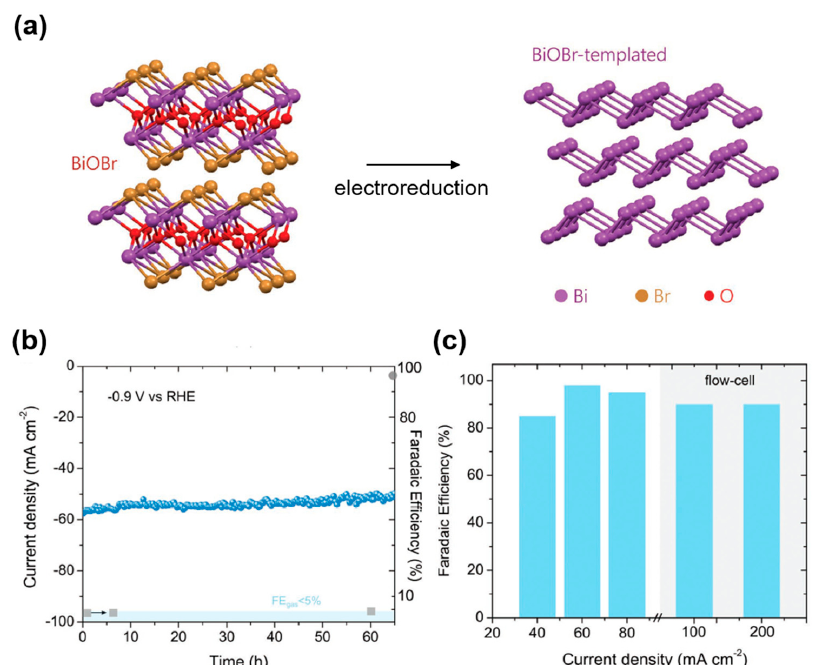
Figure 12. The characteristics of bismuth oxyhalide-templated catalysts. ( a ) Atomic structures of BiOBr and BiOBr-templated via the electroreduction process. ( b ) Long-term operating examination of liquid-phase CO 2 reduction reaction. ( c ) comparison of liquid- and gas-phase (flow-cell) reactor for BiOBr catalyst. Reprinted with permission from Reference [15].